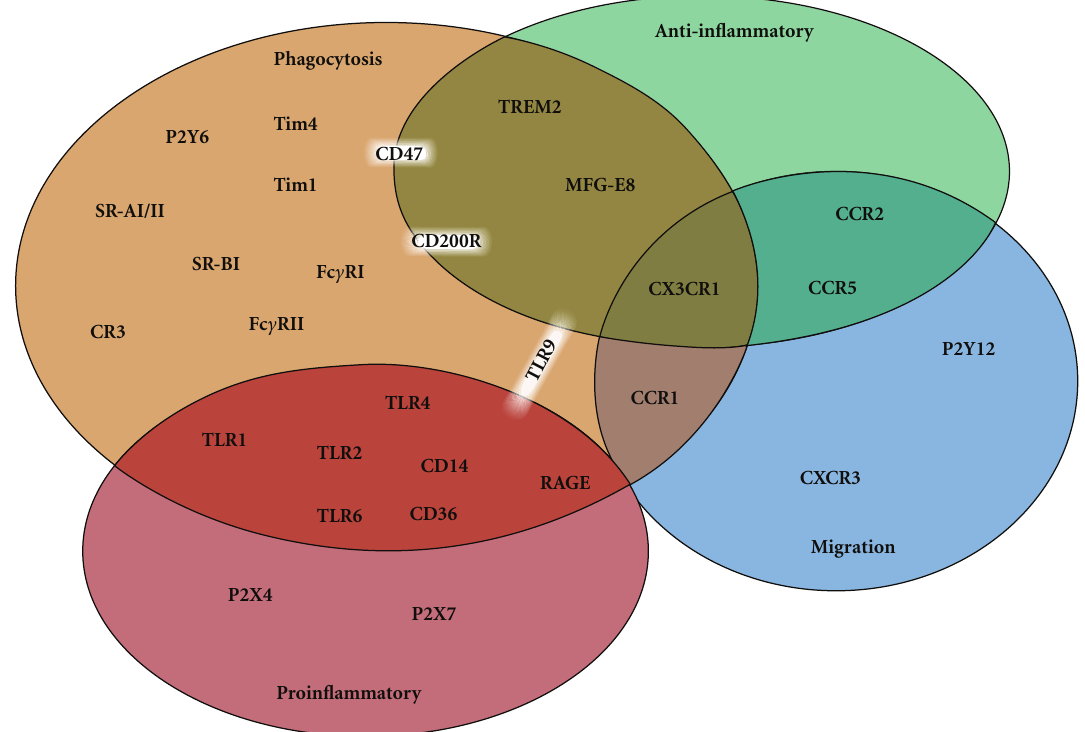
Figure 1: Chemotaxis or phagocytosis-involved receptors in microglia and correlation of the inflammatory or anti-inflammatory response. Many of the receptors correlated with microglial activities of chemotaxis (migration) or phagocytosis, respectively. Among these, some of the receptors possess not merely single function; CCR1 is the migration-inducing receptor that also possesses phagocytotic activity. CCR2 and CCR5 are also the migration-inducting receptors that lead to anti-inflammatory response. CX3CR1 contributes to migration, phagocytosis, and anti-inflammatory response. TREM2 and MFG-E8 induce phagocytosis and anti-inflammatory response. CD47 and CD200R usually induce phagocytosis under pathological condition, so that they indirectly contribute to anti-inflammatory status. TLR9 activates microglia to induce phagocytosis with producing proinflammatory and anti-inflammatory molecules. There are receptors inducing not only phagocytosis but also inflammatory response (CD14, CD36, RAGE, TLR1, TLR2, TLR4, and TLR6). Within these receptors that the synergistic signaling involved A β -triggering inflammatory response are CD14-TLR2-TLR4 and